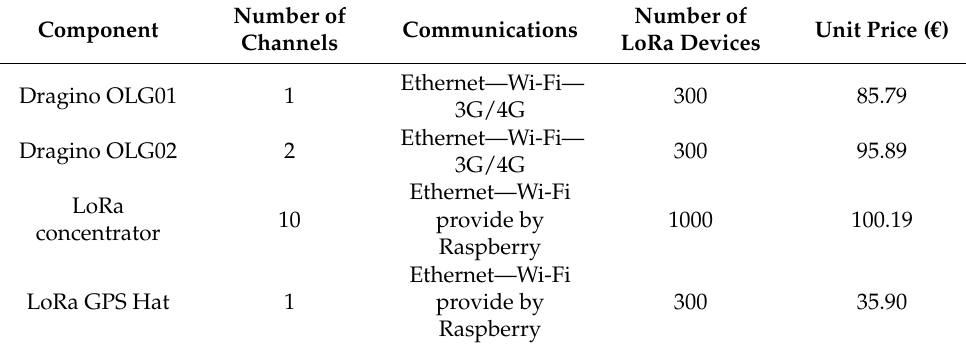
Table 2. Long Range (LoRa) gateways